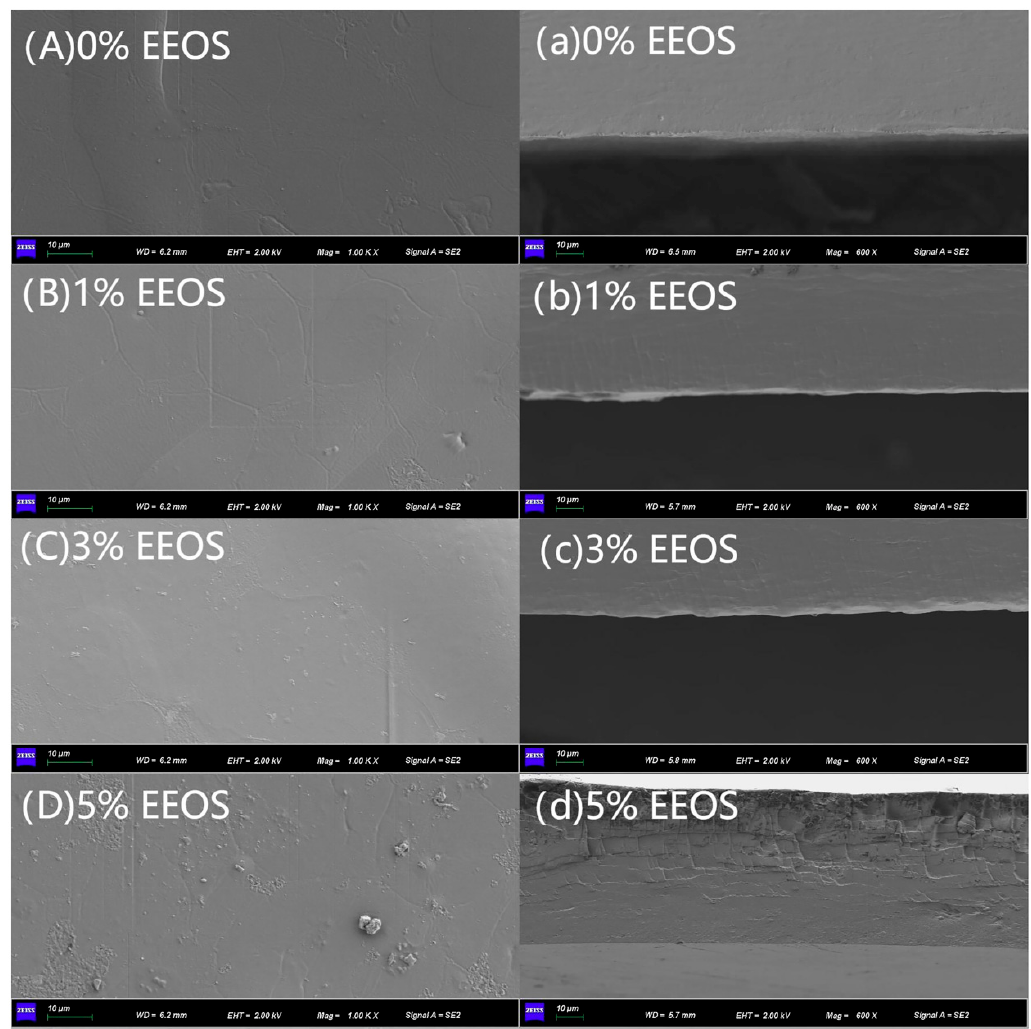
Figure 3. SEM micrographs of the surfaces and cross-sections of composite films. ( A – D ) are the surfaces, and ( a – d ) are the cross-sections of composite films.